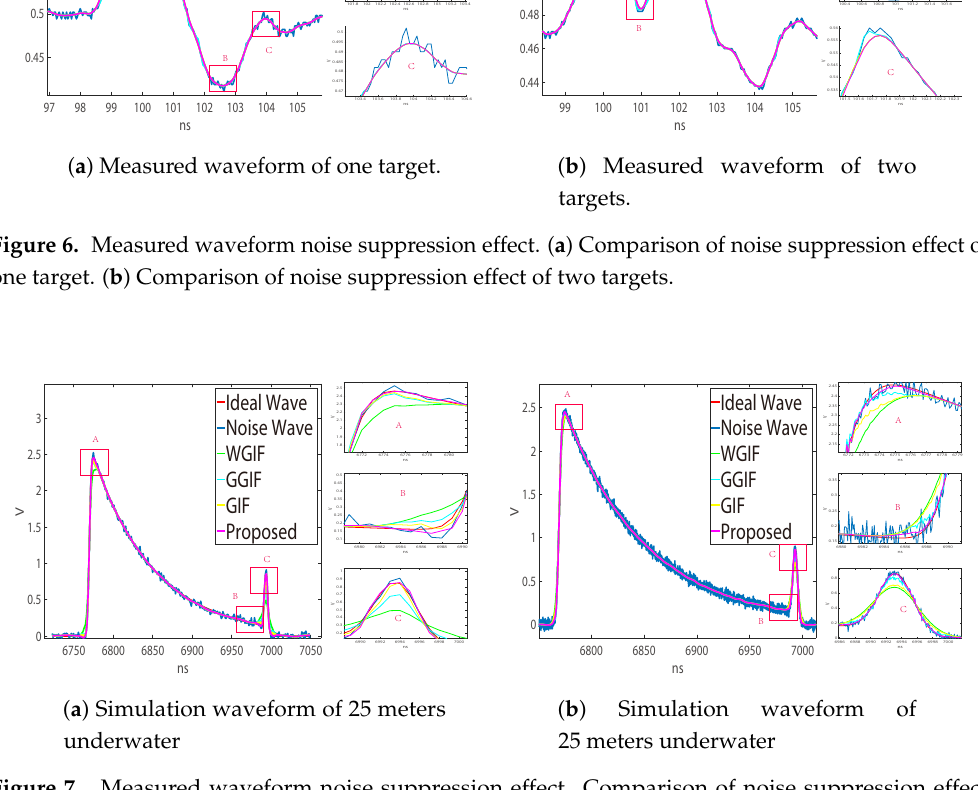
Figure 7. Measured waveform noise suppression effect. Comparison of noise suppression effect. ( a ) Filtering effect at f p = 1 GHz, SNR = 30. δ = 4 in WGIF, GGIF, and GIF, δ = 3–5 in AGGF (proposed). ( b ) Filtering effect at f p = 7.5 GHz, SNR = 30. δ = 11 in WGIF, GGIF, and GIF, δ = 9–13 in AGGF